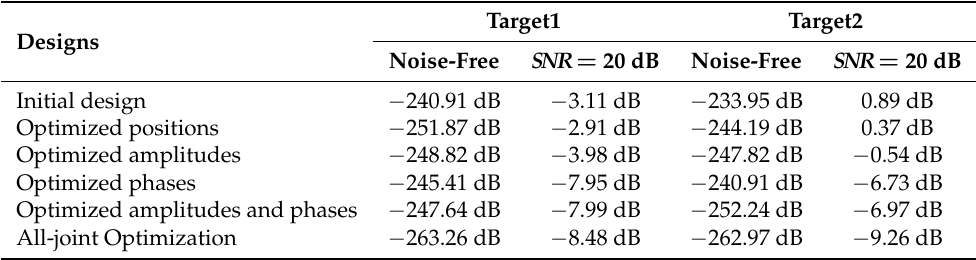
Figure 14. Imaging targets of SRFS-MSCI. Table 3. RIE of different designs in